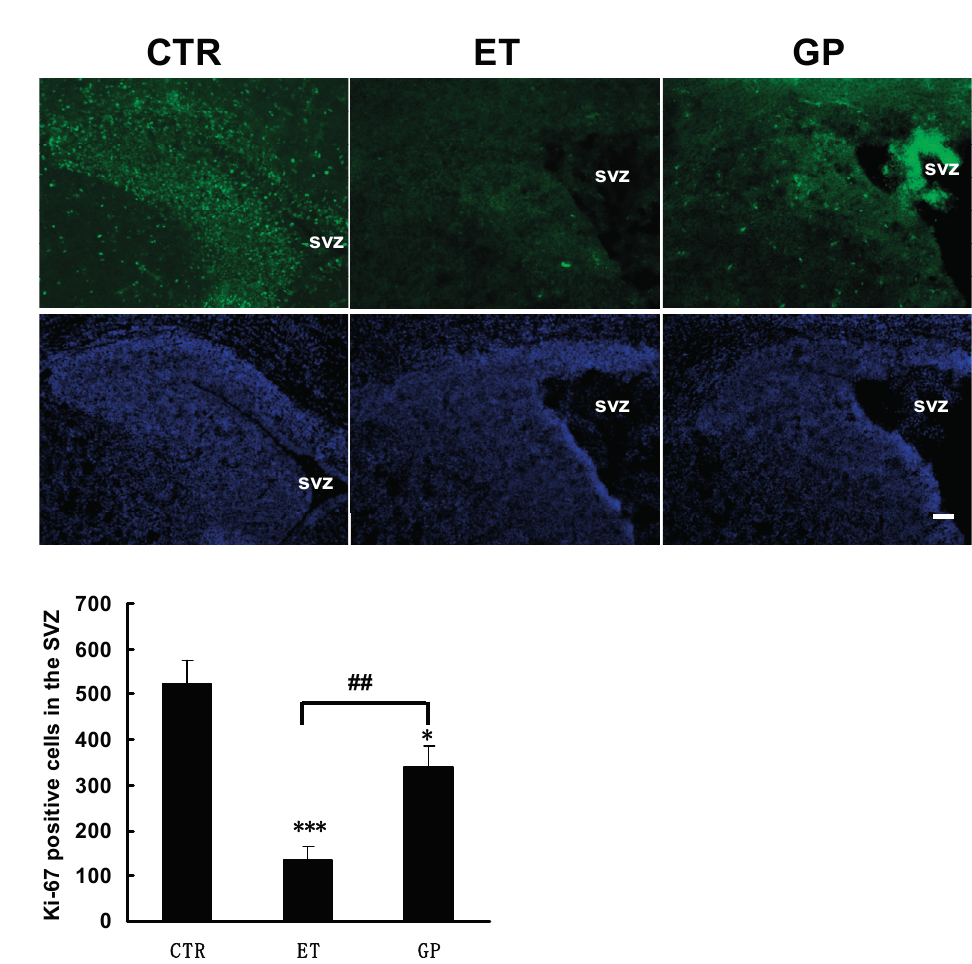
Figure 2. GPs increased the cell proliferation of neural stem cells in the SVZ of neonatal brain that were inhibited by ethanol. ( A ) Immunohistochemical staining for Ki67 was labeled in the SVZ of neonatal FASD rats. DAPI (blue) labeled all nuclei. Scale bar = 200 μ m and ( B ) Quantitative analysis of the number of Ki67-positive cells in the SVZ. * p < 0.05